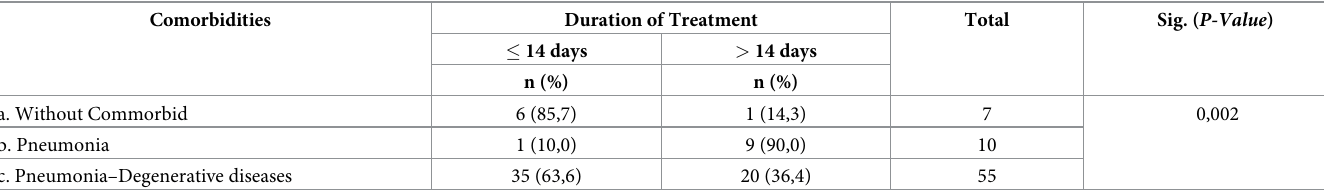
Table 3. Correlation between comorbidities and duration of treatment.